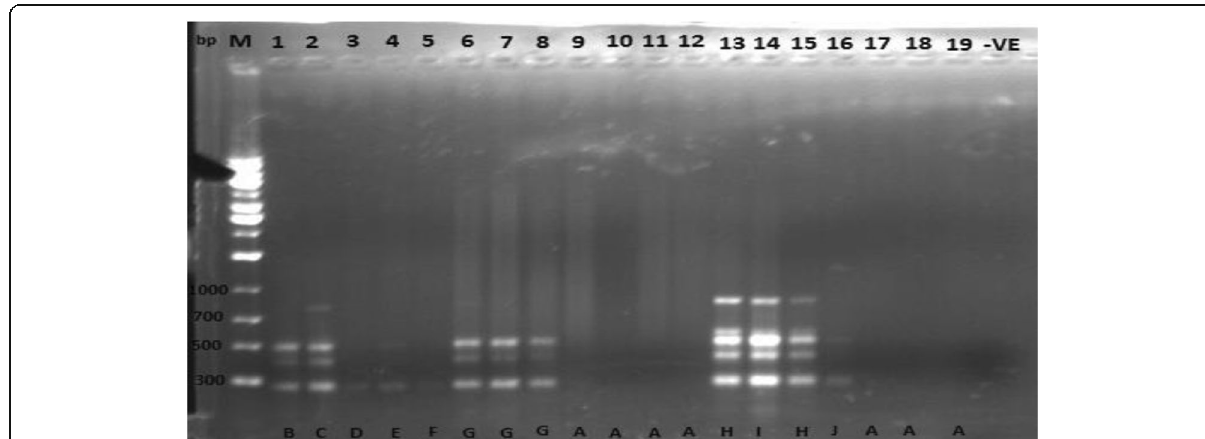
Fig. 2 RAPD agarose gel electrophoresis with OPC 04 (5 ′ -CCG CAT CTA C-3 ′ ) primer. Same alphabet indicates identical banding pattern. A, Non- type-able DNA; − VE, Negative control; bp, Base pairs; M, 1 kb DNA molecular marker. 1, FARO-44 (control); 2, FARO-52 (control); 3, FARO-57 (control); 4, NERICA L-34 (control); 5, NERICA L-47 (control); 6, FARO-44 (0% NaN 3 ); 7, FARO-44 (0.004% NaN 3 ); 8, FARO-44 (0.016% NaN 3 ); 9, FARO- 52 (0.004% NaN 3 ); 10, FARO-52 (0.008% NaN 3 ); 11, FARO-52 (0.016% NaN 3 ); 12, FARO-57 (0% NaN 3 ); 13, FARO-57 (0.008% NaN 3 ); 14, FARO-57 (0.016% NaN